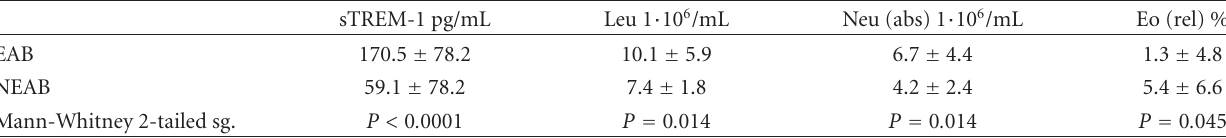
Table 3: Comparison of plasma levels of investigated parameters in asthma bronchiale patients with and without exacerbation.